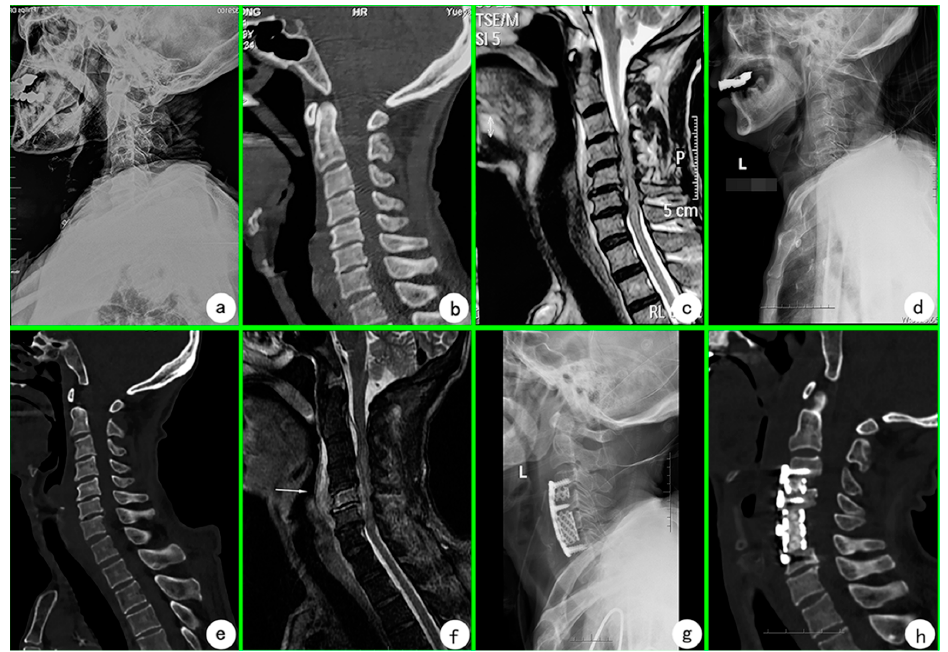
Figure 1. A 70-year-old male patient was admitted with neck and shoulder pain accompanied by numbness and fatigue for 12 days. ( a ) Cervical X-ray at 6 days after vaccination (D6) showed straightening of cervical curvature and hyperosteogeny. ( b ) On D6, plain CT scan of cervical spine showed hyperosteogeny of cervical spine and slight herniation of C3/4, C4/5, and C5/6 intervertebral discs. ( c ) On D6, cervical MRI plain scan showed cervical instability, spinal cord degeneration at C3 to C6 vertebral body level, backward disc herniation at C3/4, C4/5, C5/6, and C6/7, and spinal canal stenosis at C6/7 level. ( d ) Cervical X-ray at 15 days after vaccination (D15) showed possible intervertebral lesions of C5/6 and C6/7. ( e ) On D15, CT scan of cervical spine showed increased density in the right margin of C5 and C6 vertebrae: nature undetermined, C2/3 and C3/4 disc slightly protruded backwards. ( f ) On D15, MRI plain scan of cervical spine showed abnormal signals of spinal cord at the level of C3 to C6 vertebrae, compressive changes of C5 vertebrae and abnormal signals and flattening of C5/6 intervertebral disc. The cause is to be investigated: infectious lesions. ( g , h ) Postoperative cervical X-ray and CT plain scan showed normal physiological lordosis of cervical spine, good position of internal fixation device, no loosening, fracture, prolapse or